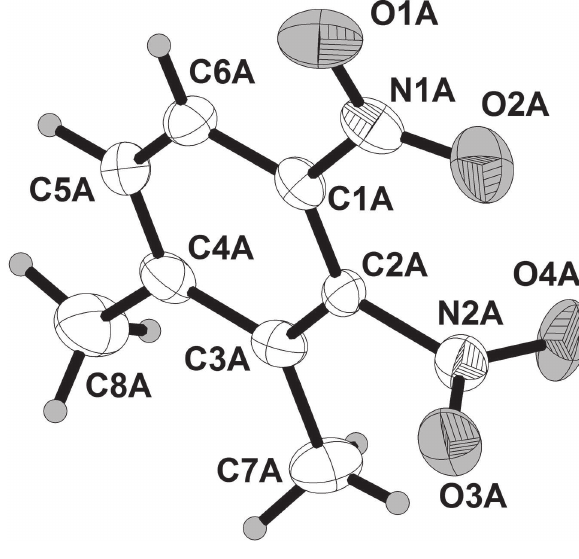
Table 1: Data collection and handling.